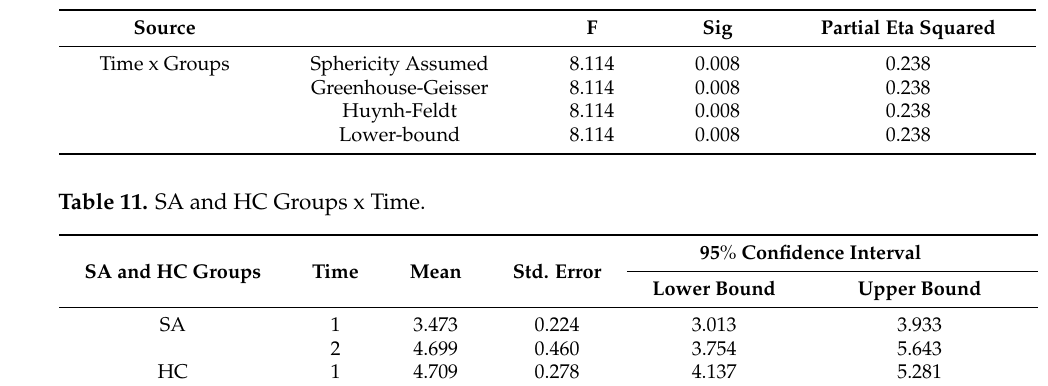
Table 10. Tests of Within-Subjects Effects for High Voltage.